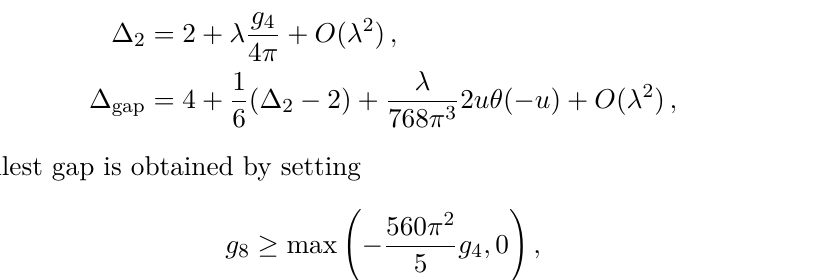
Figure 8 . The maximal value of the gap as a function of ∆ 2 with (∆ 1 , c 112 , c 222 ) as given, which to first order corresponds to switching on only the g 4 deformation. The best bound was obtained with Λ = 30 ; the slightly weaker bound with Λ = 20 . At the free point the numerical bound appears to become tangent to the line 4 + 1 (∆ 2 − 2) . The free theory (red dashed line) can only explain this 6 bound for ∆ 2 > 2 . By selectively switching on a φ 8 interaction (blue line) we can also saturate the bound to first order in perturbation theory for ∆ 2 < 2